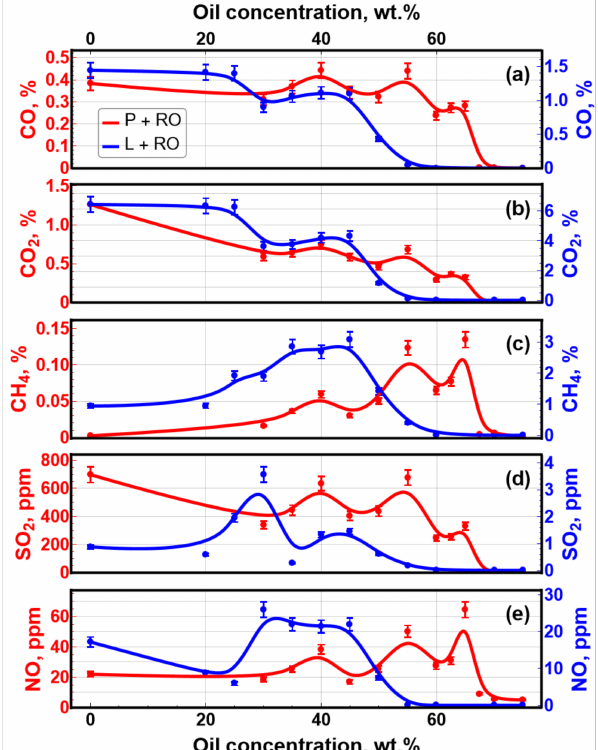
Figure 5. Chemical composition of producer gas for different fossil fuel—renewable component ratios in the composite fuel. The gas trends are shown in subfigures: CO ( a ), CO 2 ( b ), CH 4 ( c ), SO 2 ( d ), NO ( e ). The optimal fuel compositions are 35 wt% peat and 65 wt% rapeseed oil; 60 wt% lignite and 40 wt% rapeseed